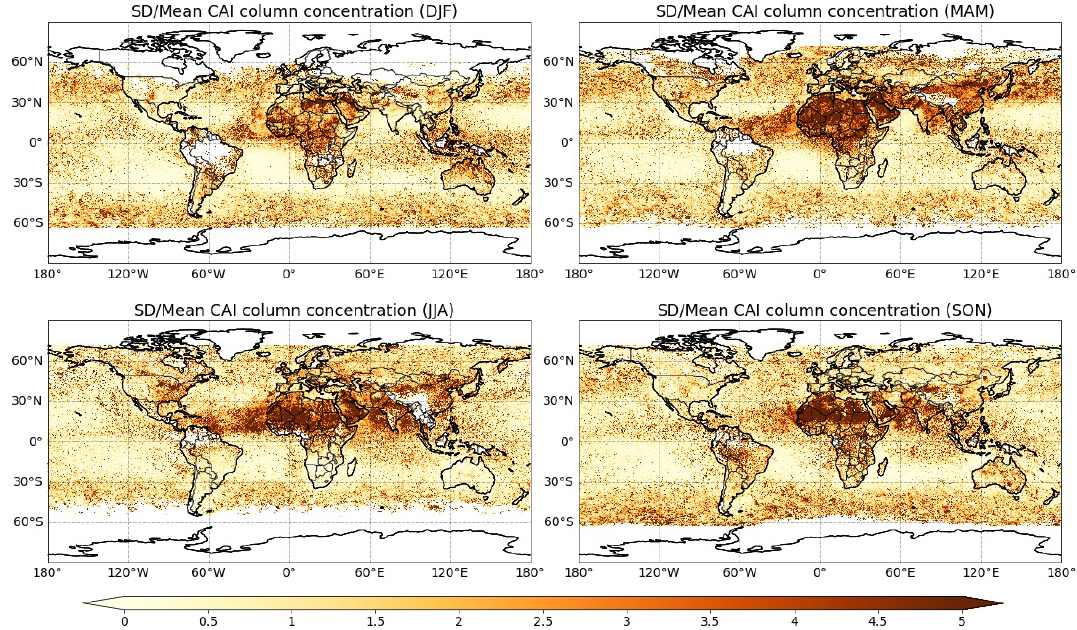
Figure 9. The standard deviation (SD)/mean for seasonal CAI column mass concentration in Fig. 8 derived from POLDER-3